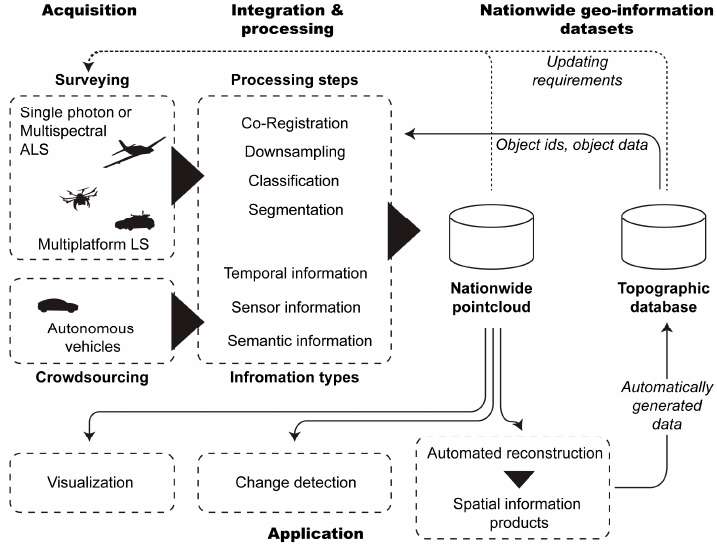
Figure 7. Overview: acquisition, processing, and application of a dense point cloud.